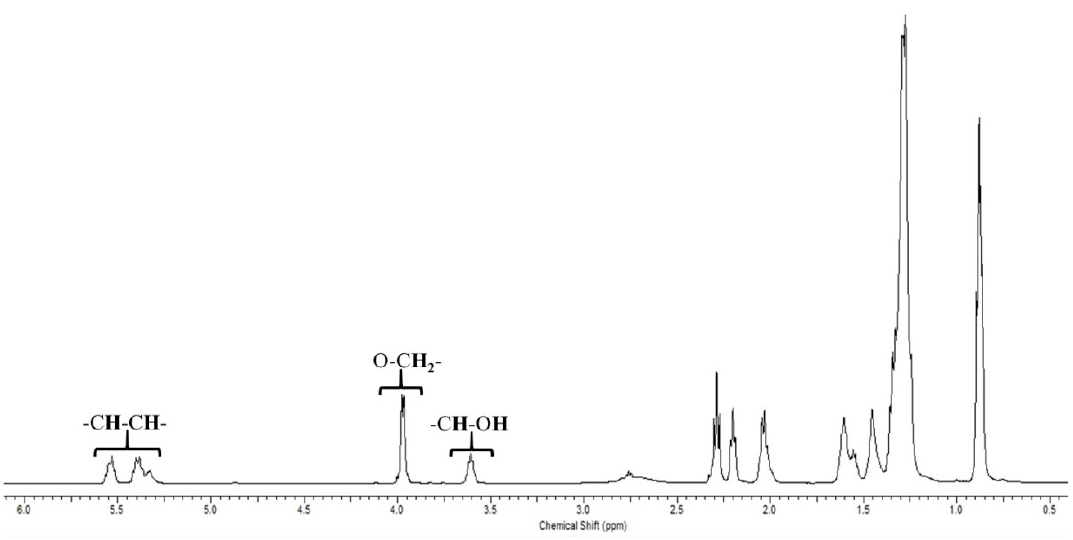
Figure 11. 1 H NMR spectrum of the obtained ester after the esterification reaction between FACO and EH.